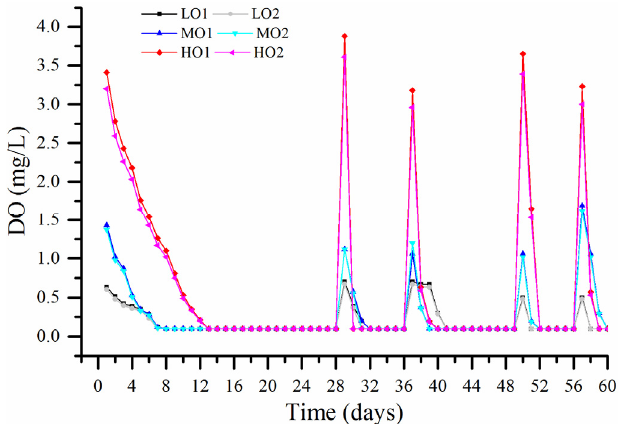
Figure 1. Dissolved oxygen variation for wines treated with different oxygen exposure. Abbreviations: DO, dissolved oxygen; LO, low-level oxygenation wine (0.5–0.9 mg O 2 /L per time); MO, medium-level oxygenation wine (1–1.9 mg O 2 /L per time); HO, high-level oxygenation wine (3–3.9 mg O 2 /L per time).